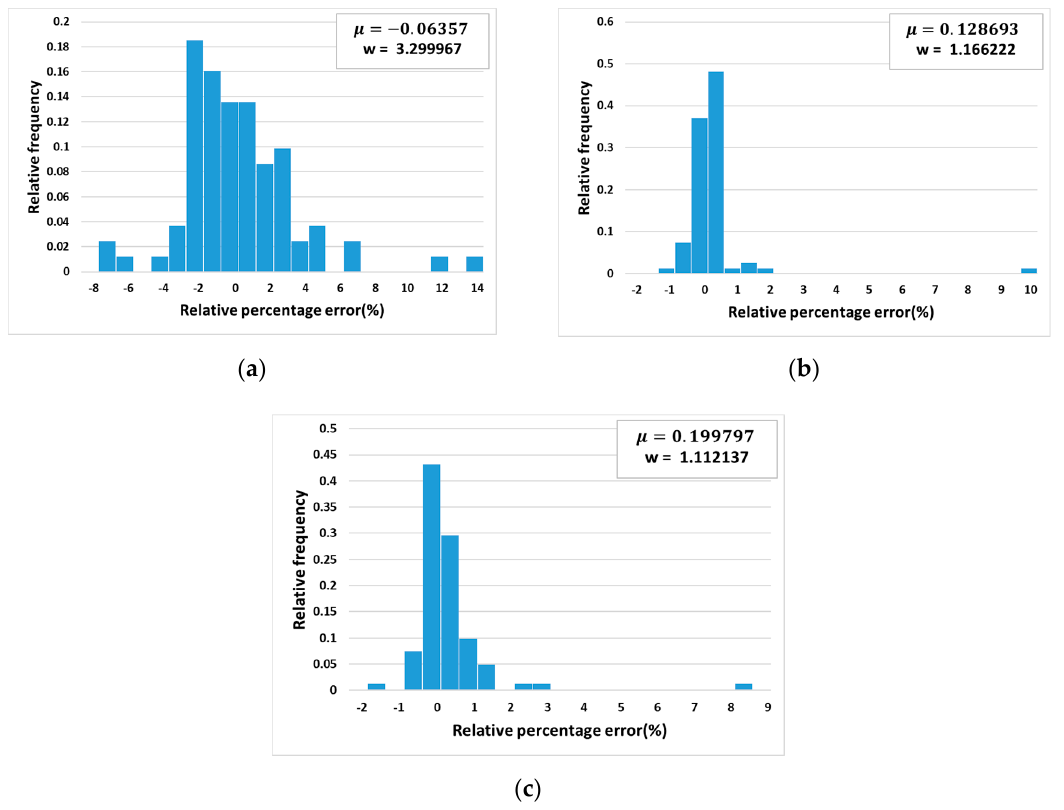
Figure 11. Relative frequency vs. relative percentage error using ( a ) Arrhenius equation; ( b ) Neural network; ( c ) Support vector regression.